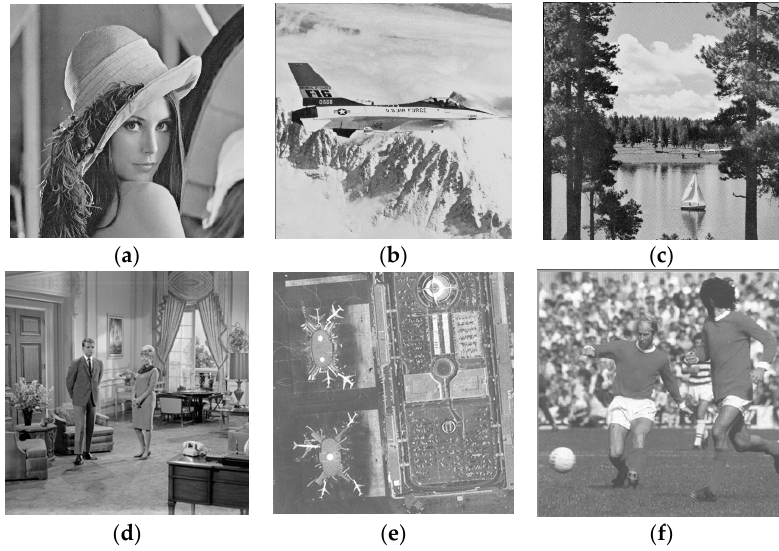
Figure 6. Watermarked images: ( a ) Lena; ( b ) Airplane; ( c ) Boat; ( d ) Couple; ( e ) Lax; ( f ) Best_cha.